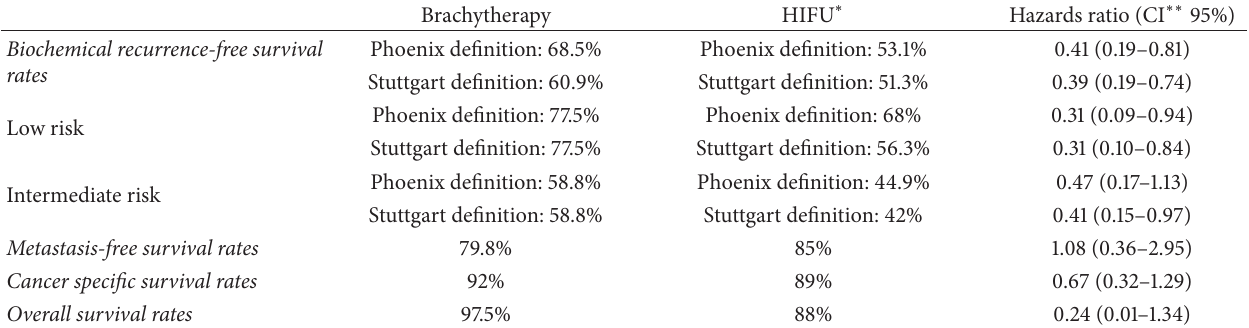
Table 3: Oncologic outcomes for the cohort stratified according to the D’Amico risk classification.